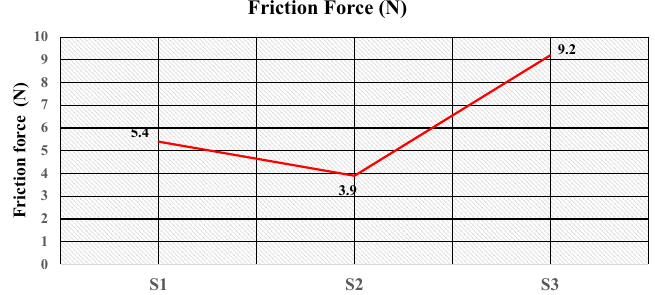
Figure 19. Friction force of the specimens.